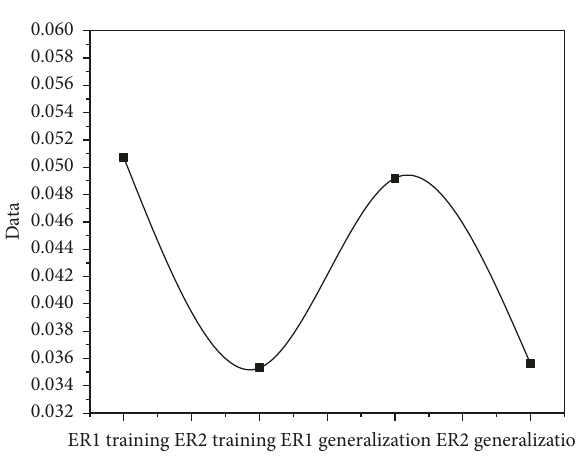
Figure 3: GA model simulation results.